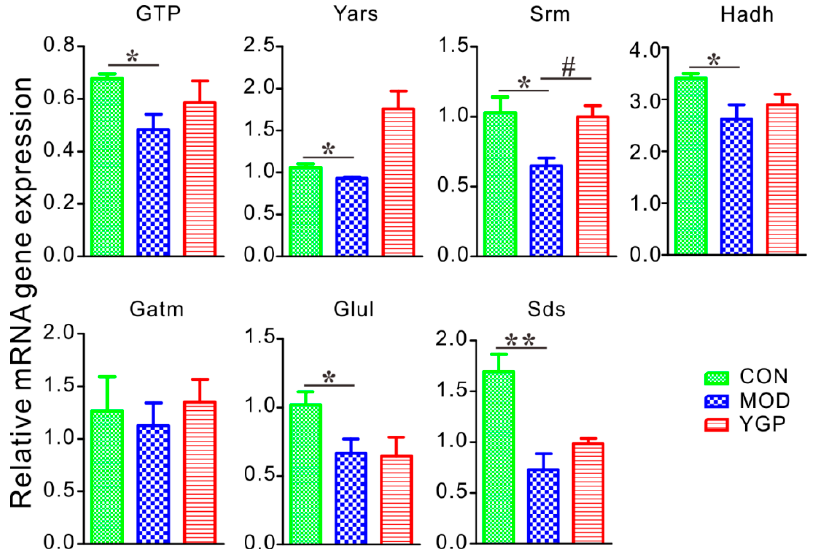
Figure 7. YGP regulates KYDS-related di ff erential gene expression. All genes expression are examined by RT-qPCR and normalized to β -actin expression. Data represent mean ± SEM for at least three independent experiments; * p < 0.05, ** p < 0.01; # p < 0.05, ## p < 0.01.